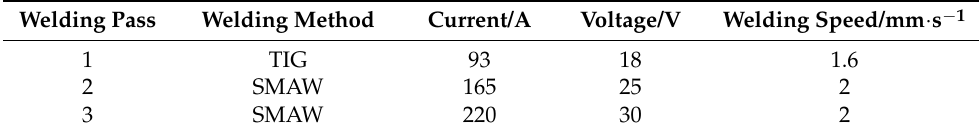
Table 1. Welding parameters.